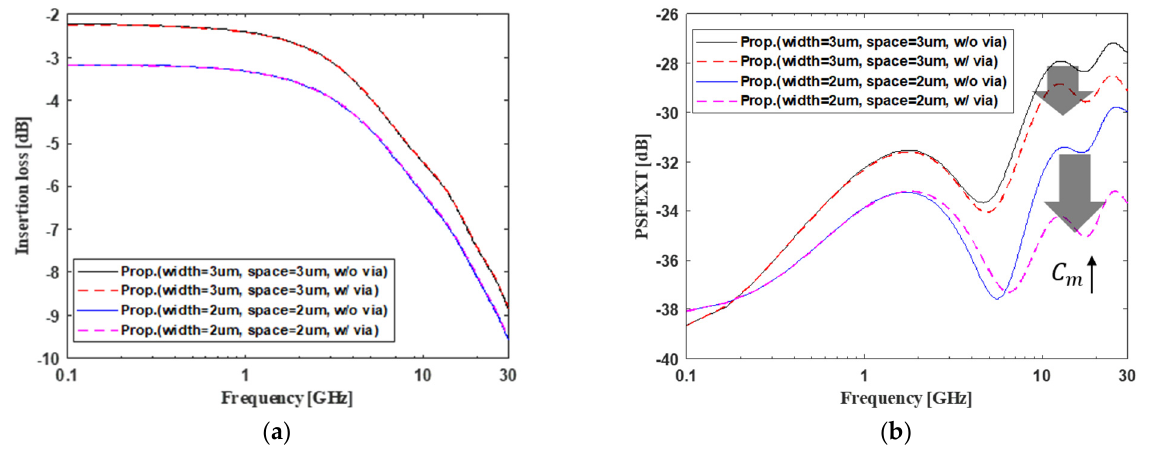
Figure 6. Signal integrity analysis of the effect of the proposed channel structure on the vertical tabbed via in the frequency domain. ( a ) Insertion loss and ( b ) power sum far-end crosstalk (PSFEXT).